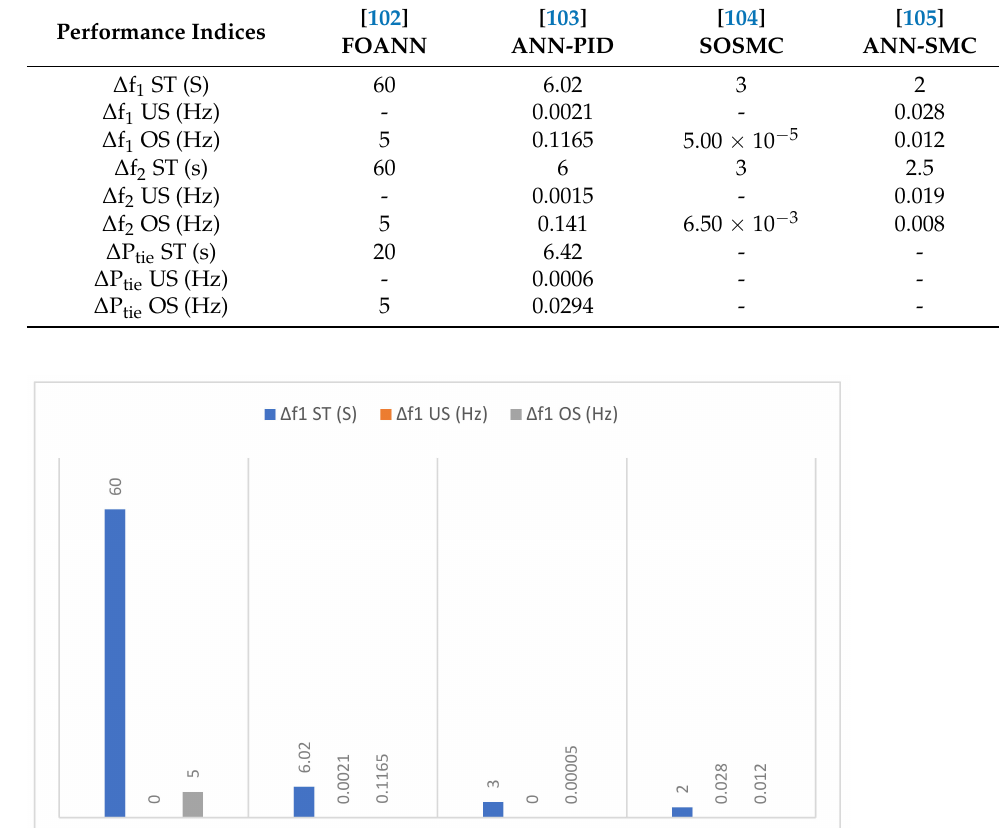
Table 5. Performance Indices of ANN Controller in an Interconnected Power System.